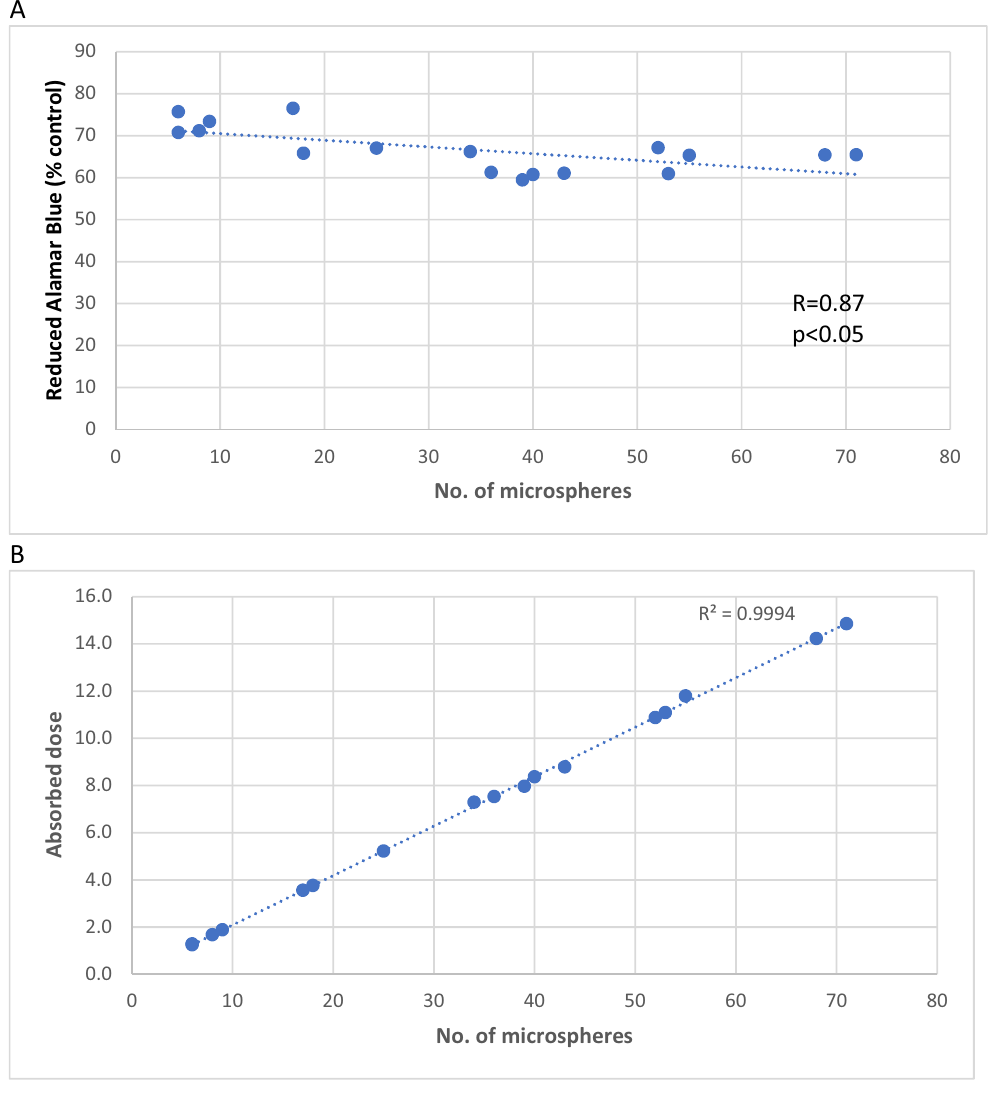
Figure 5. A. Correlation between number of microspheres and mitochondrial activity measured by Alamar Blue in normoxia after a 48-h exposure. B. Correlation between number of microspheres and absorbed dose in normoxia after a 48-h exposure.